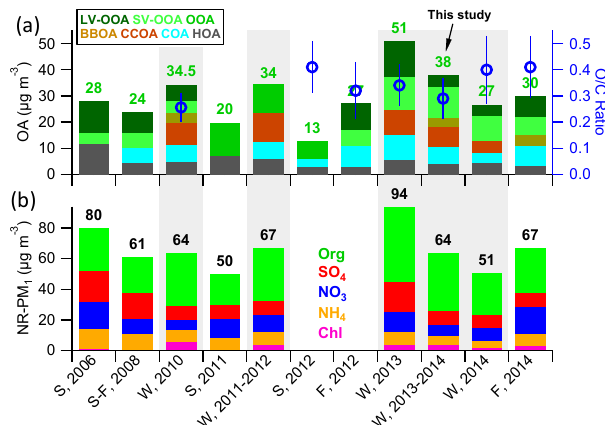
Figure 2. Average chemical composition of (a) organic aerosols and (b) NR-PM 1 in the megacity of Beijing measured by aerosol mass spectrometers. Also shown in panel (a) is the oxygen-to-carbon (O / C) ratio of organic aerosol for each study. The O / C was cal- culated using the A-A method (Aiken et al., 2008). A more detailed description of the data is presented in Table